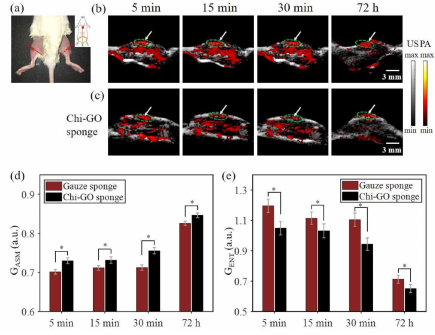
Figure 6. In vivo PAT assessment results. ( a ) Picture of mouse hemorrhage model. US/PA images of bleeding site from gauze sponge ( b ) and Chi-GO sponge ( c ) at the labeled time points. The statistic analysis of G ASM ( d ) and G ENT ( e ) of the GLCM, which are shown as mean ± SD ( n = 5), (*) p <